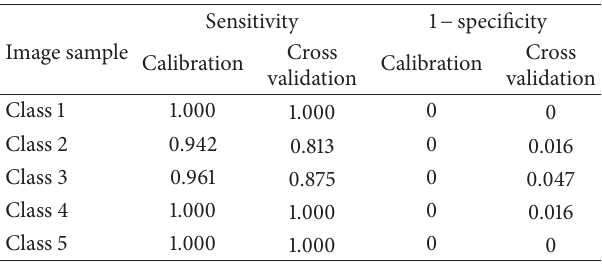
Table 3: Sensitivity and 1 − specificity values of classification model using SVM.